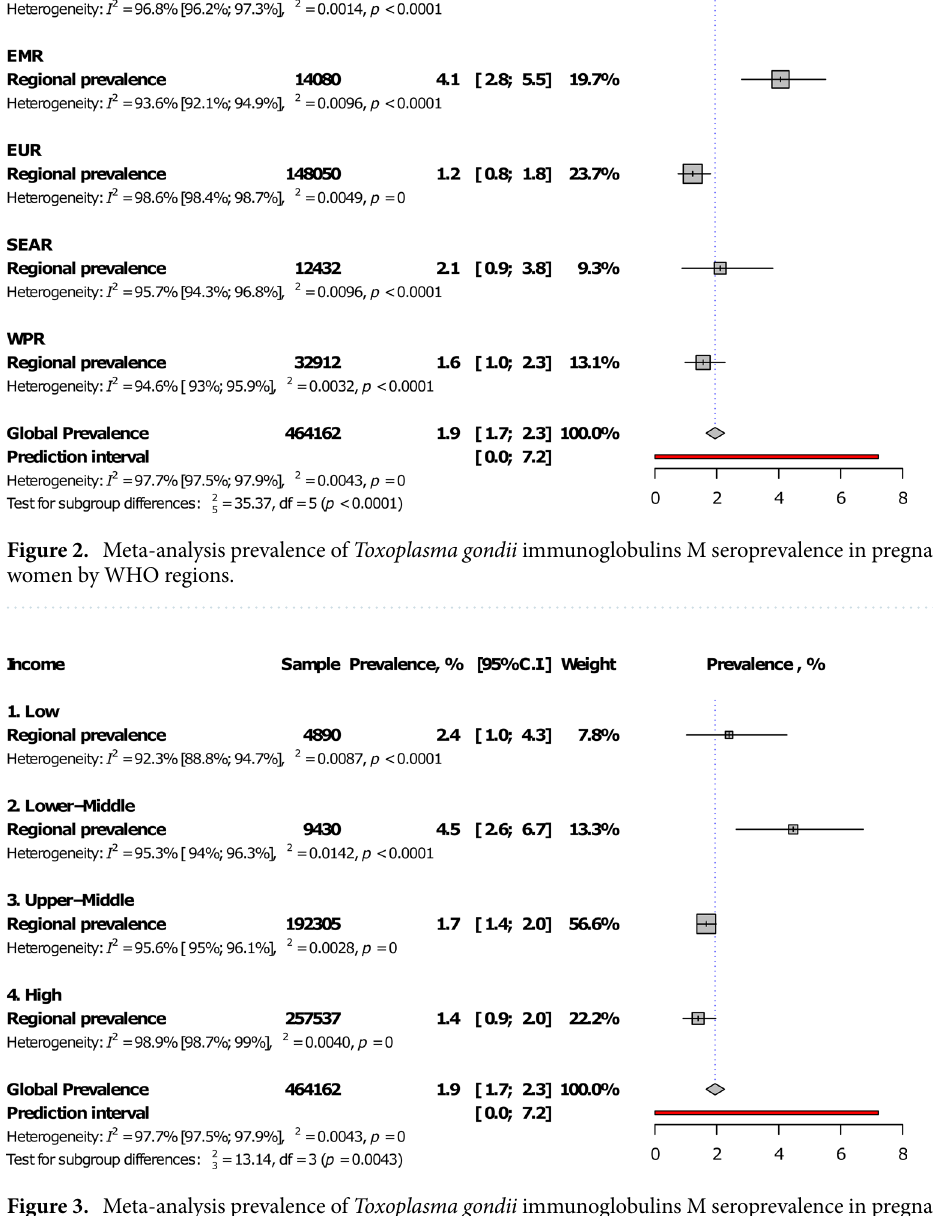
Figure 3. Meta-analysis prevalence of Toxoplasma gondii immunoglobulins M seroprevalence in pregnant women by country level of